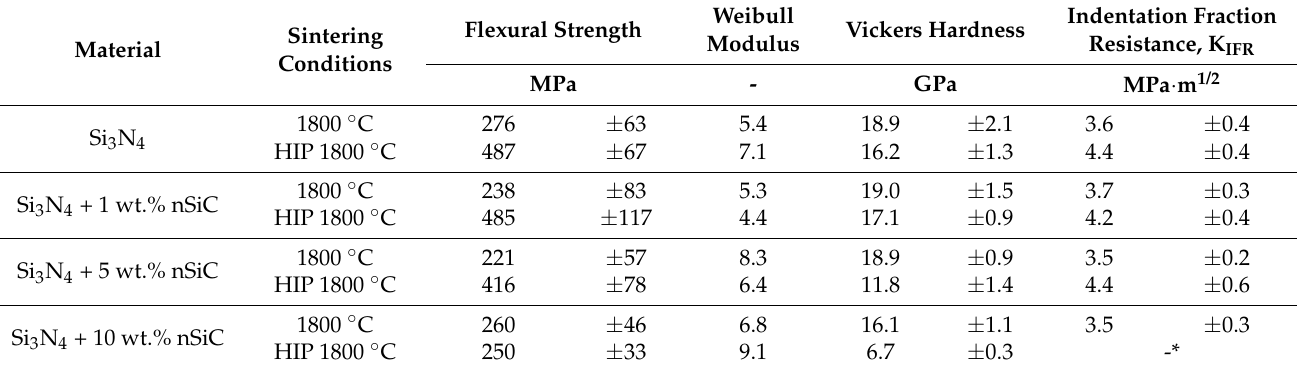
Table 3. Mechanical properties of the materials obtained by pressureless sintering at a temperature of 1800 ◦ C and in the hot isostatic press at a temperature of 1800 ◦